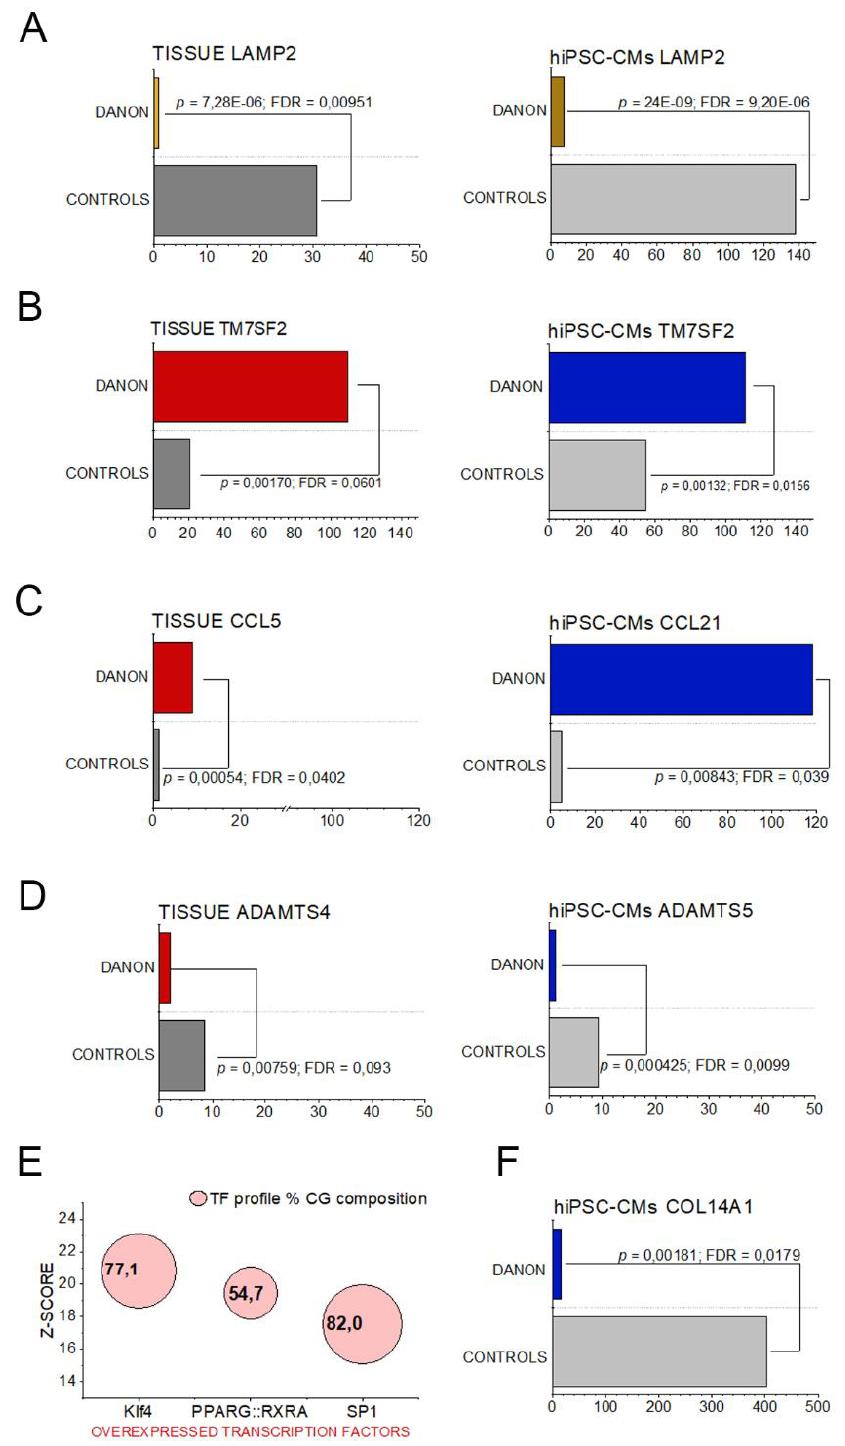
Figure 1. Representative data from the RNA-Seq of cardiac biopsies (indicated as TISSUE, left side) and hiPSC-CMs (right side). Gene expression of LAMP-2 ( A ), Delta(14)-sterol reductase TM7SF2 ( B ), Chemokines CCL21 and CCL5 ( C ), and metalloproteases (ADAMTS4 and ADAMTS5) ( D ). Overexpressed transcription factors identified using oPOSSUM bioinformatics tool with cardiac biopsies ( E ). Expression of collagen gene COL14A1 in hiPSC-CMs ( F ).